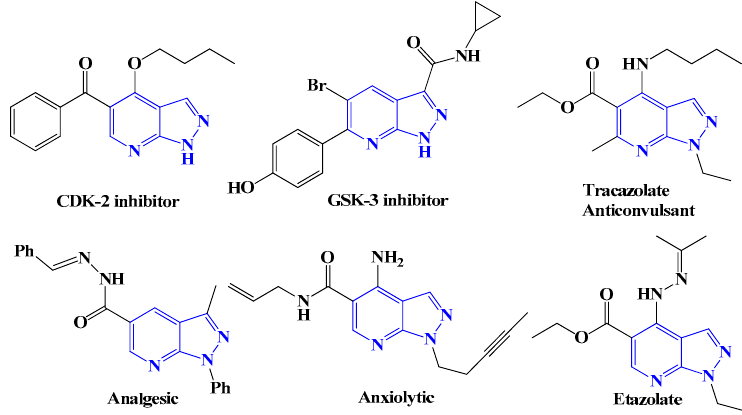
Figure 1. General structures of coumarin molecules possessing biological activity.